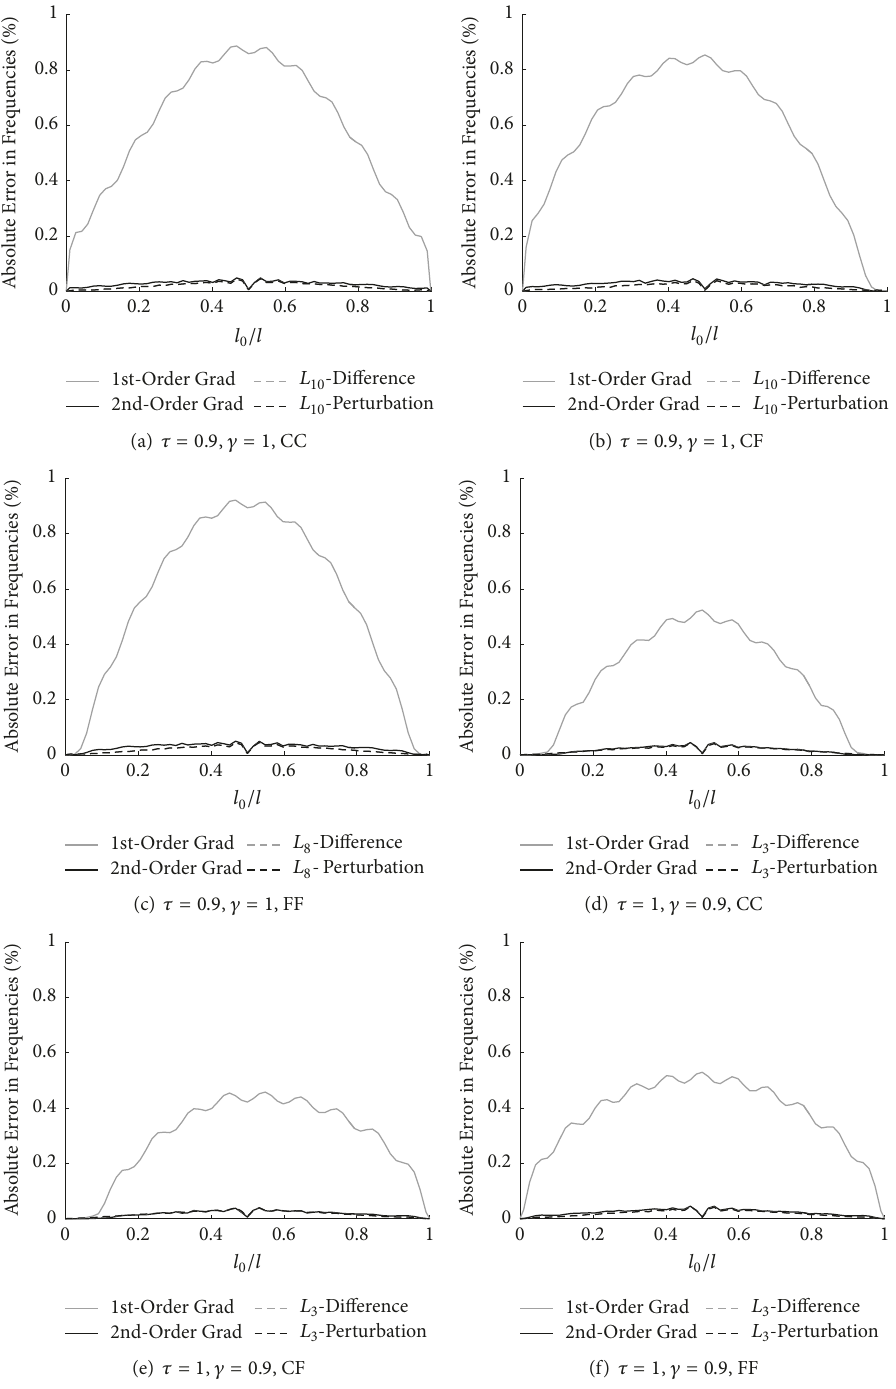
Figure 5: Frequency error results with a decrease in 𝛾 or 𝜏 for variable 𝑙 0 /𝑙